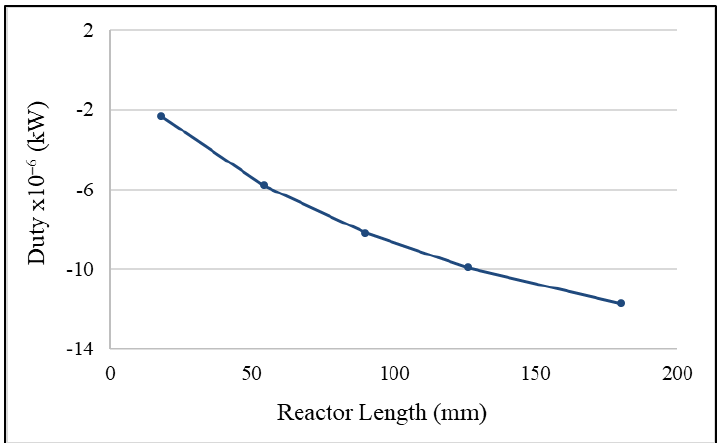
Figure 6. Duty variations along the reactor length. Reaction conditions: Pressure, 300 psig; gas phase, hydrogen; liquid phase 4-propylguaiacol; liquid flow rate, 0.03 mL ∙ min −1 ; gas flow rate, 0.09 mL ∙ min −1 .